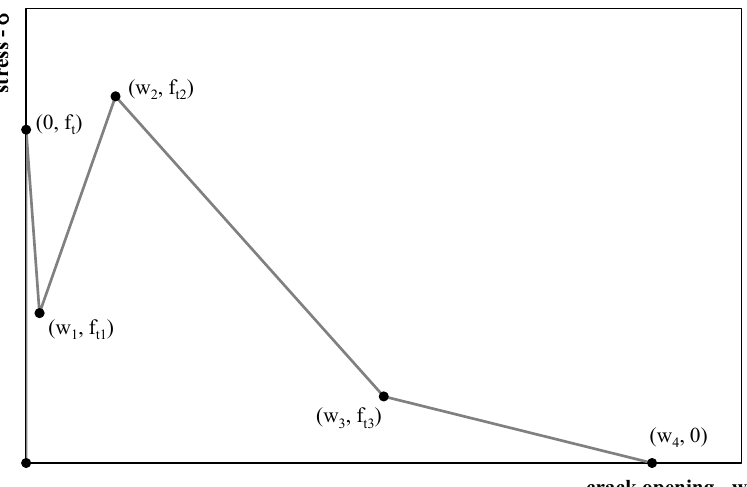
Figure 2. Stress distributions at the notch section.